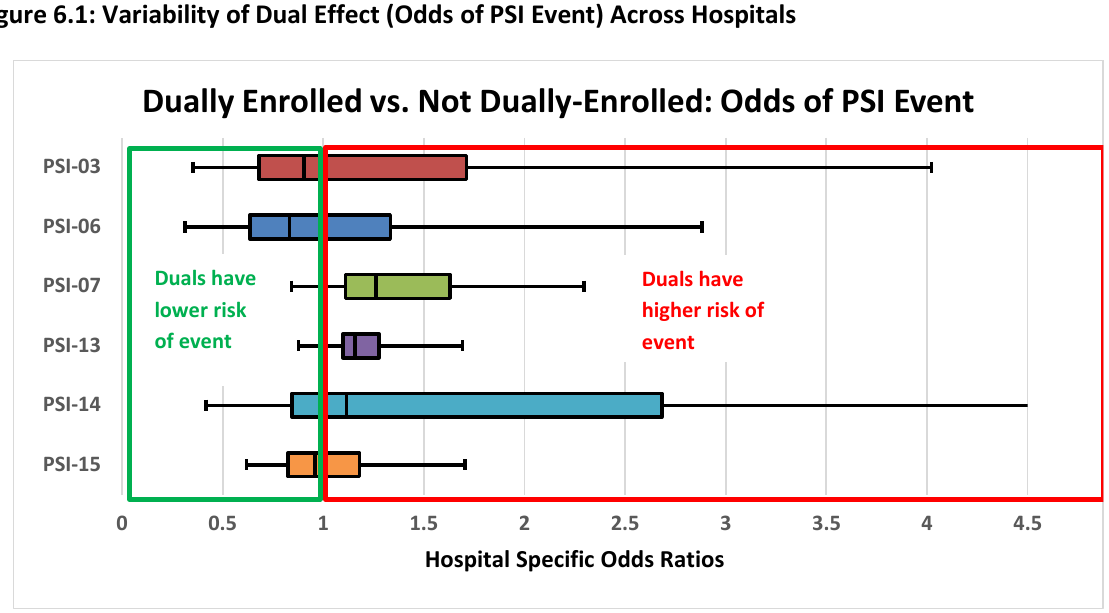
Figure 6.1: Variability of Dual Effect (Odds of PSI Event) Across Hospitals